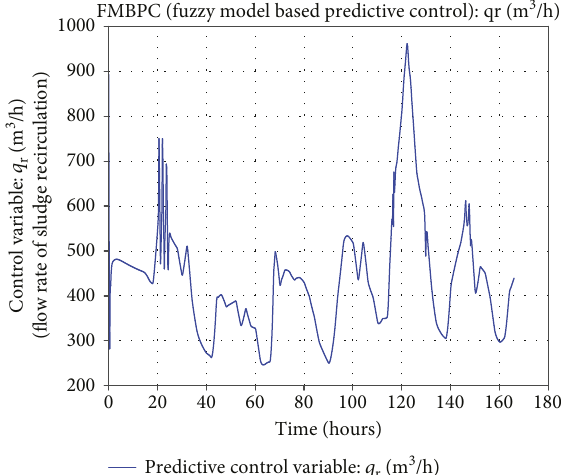
Figure 17: Biomass in the reactor and disturbances (case B).